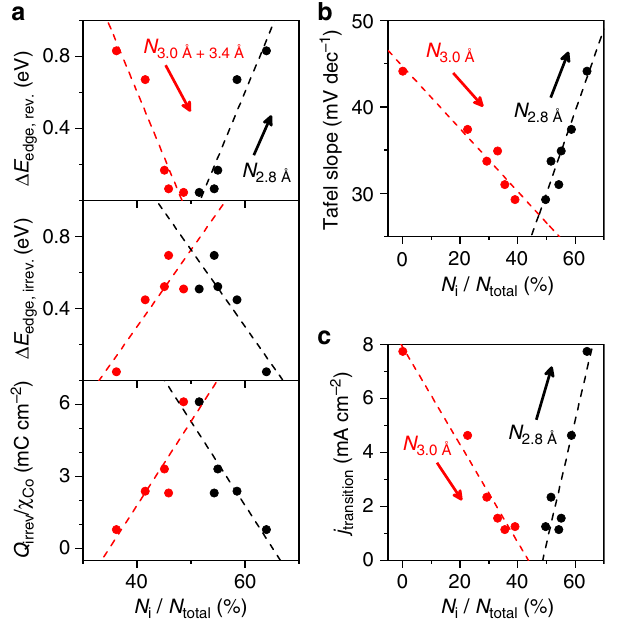
Fig. 5 Correlations between structural features and electrochemical behavior parameters. a The change in the Co K-edge position in the reversible and irreversible regions of in situ XAS-CV experiments and the normalized charge density for irreversible redox processes ( Q irrev / χ Co ). b Tafel slope. c Current density where transition between Tafel slopes occurs (Fig.